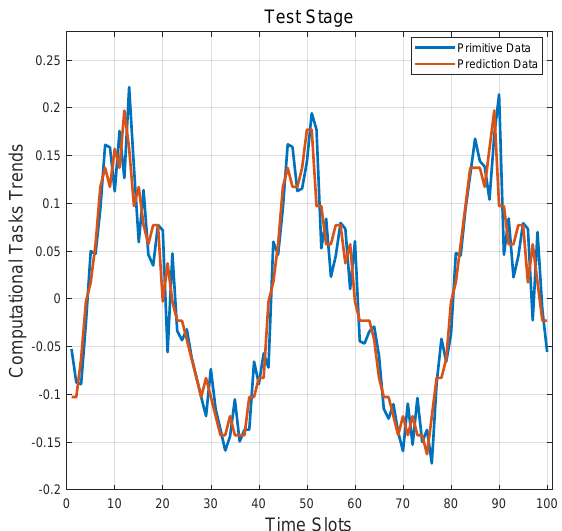
Figure 6. The test stage for LSTM-based resource availability prediction.